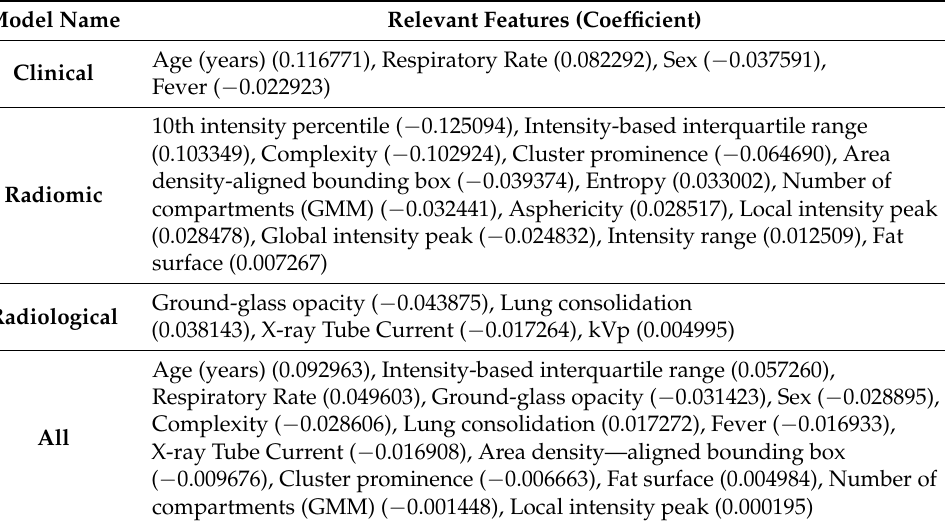
Table 3. Set of variables chosen via Lasso regression with respective weights of the linear combination in the tested version of the model. Arranged in descending order of absolute value; in all cases, the Intercept =